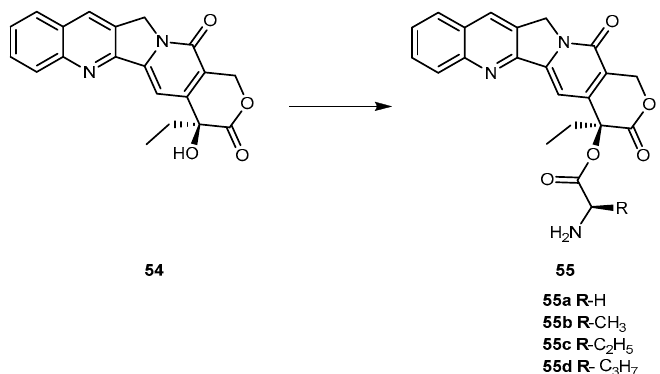
Figure 25. Structures of prodrugs of 54 .